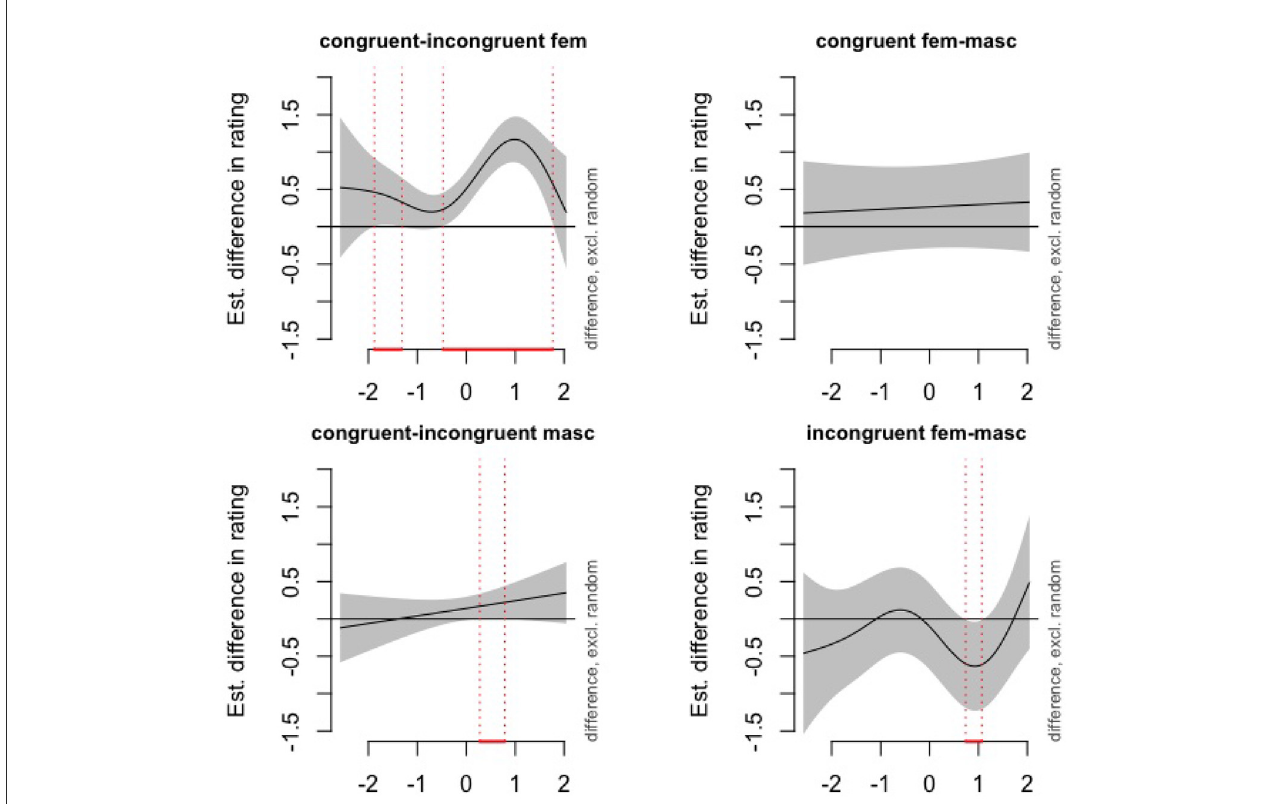
FIGURE2 Conscientiousness: Difference plots depicting the interaction between conscientiousness and stereotype congruence. More negative/positive values on the x-axis indicate lower/higher conscientiousness. (Upper left) Congruent minus incongruent female stereotyped role name; (Upper right) congruent female minus congruent male stereotyped role name; (Lower left) congruent minus incongruent male stereotyped role name; (Lower right) congruent female minus incongruent female stereotyped role name. Vertical, red, dotted lines indicate the area of significant difference.